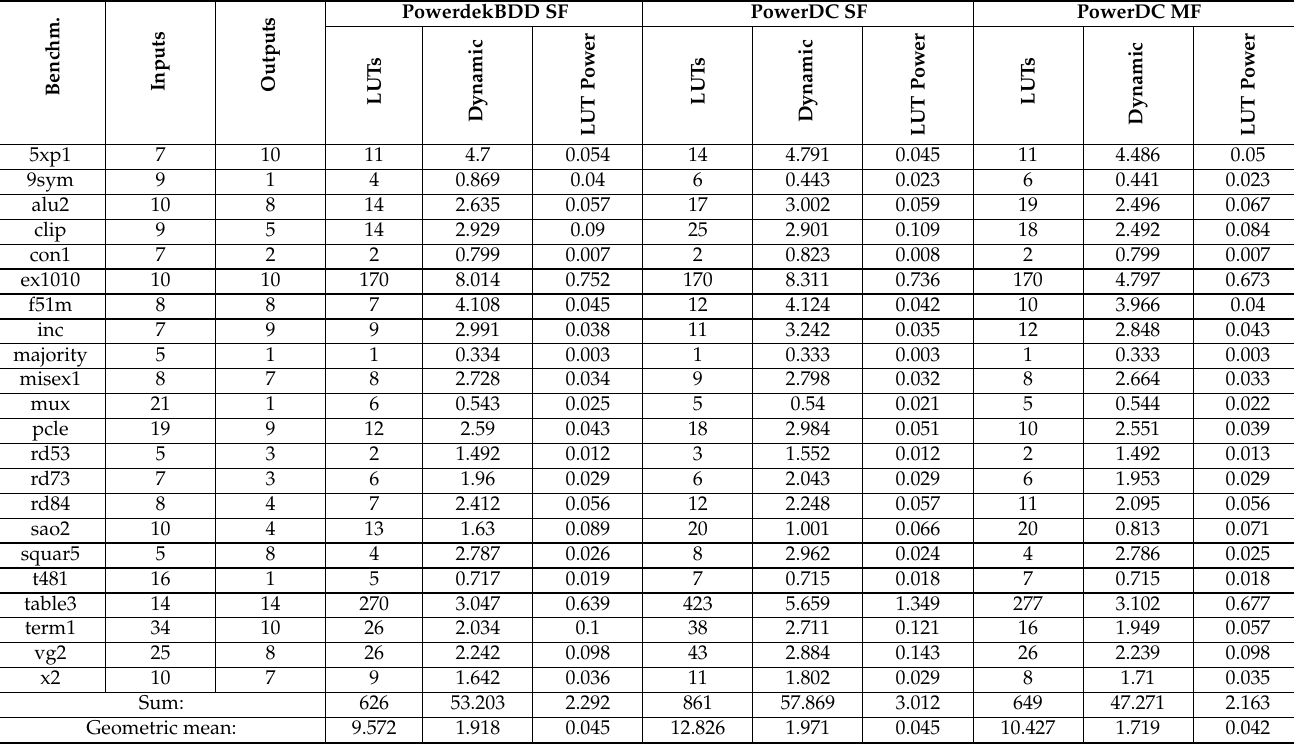
Table 2. The results of the experiments obtained with the use of the Vivado tool.